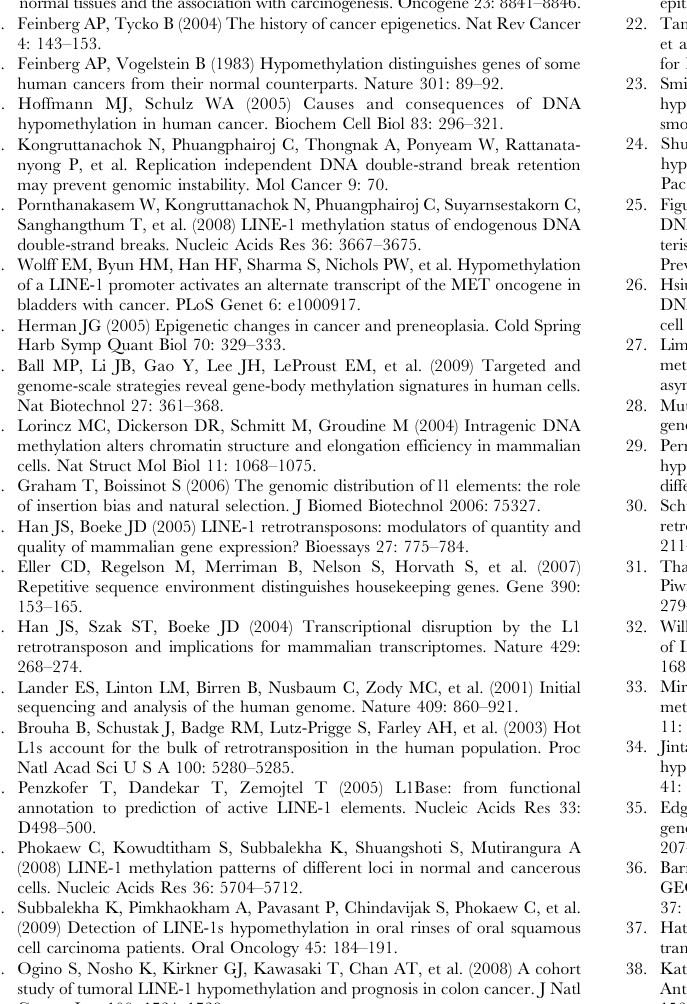
Table S5 The 2 6 2 contingency tables corresponding to genes possessing internal L1s which were down-regulated in both cancer and demethylated normal cells.